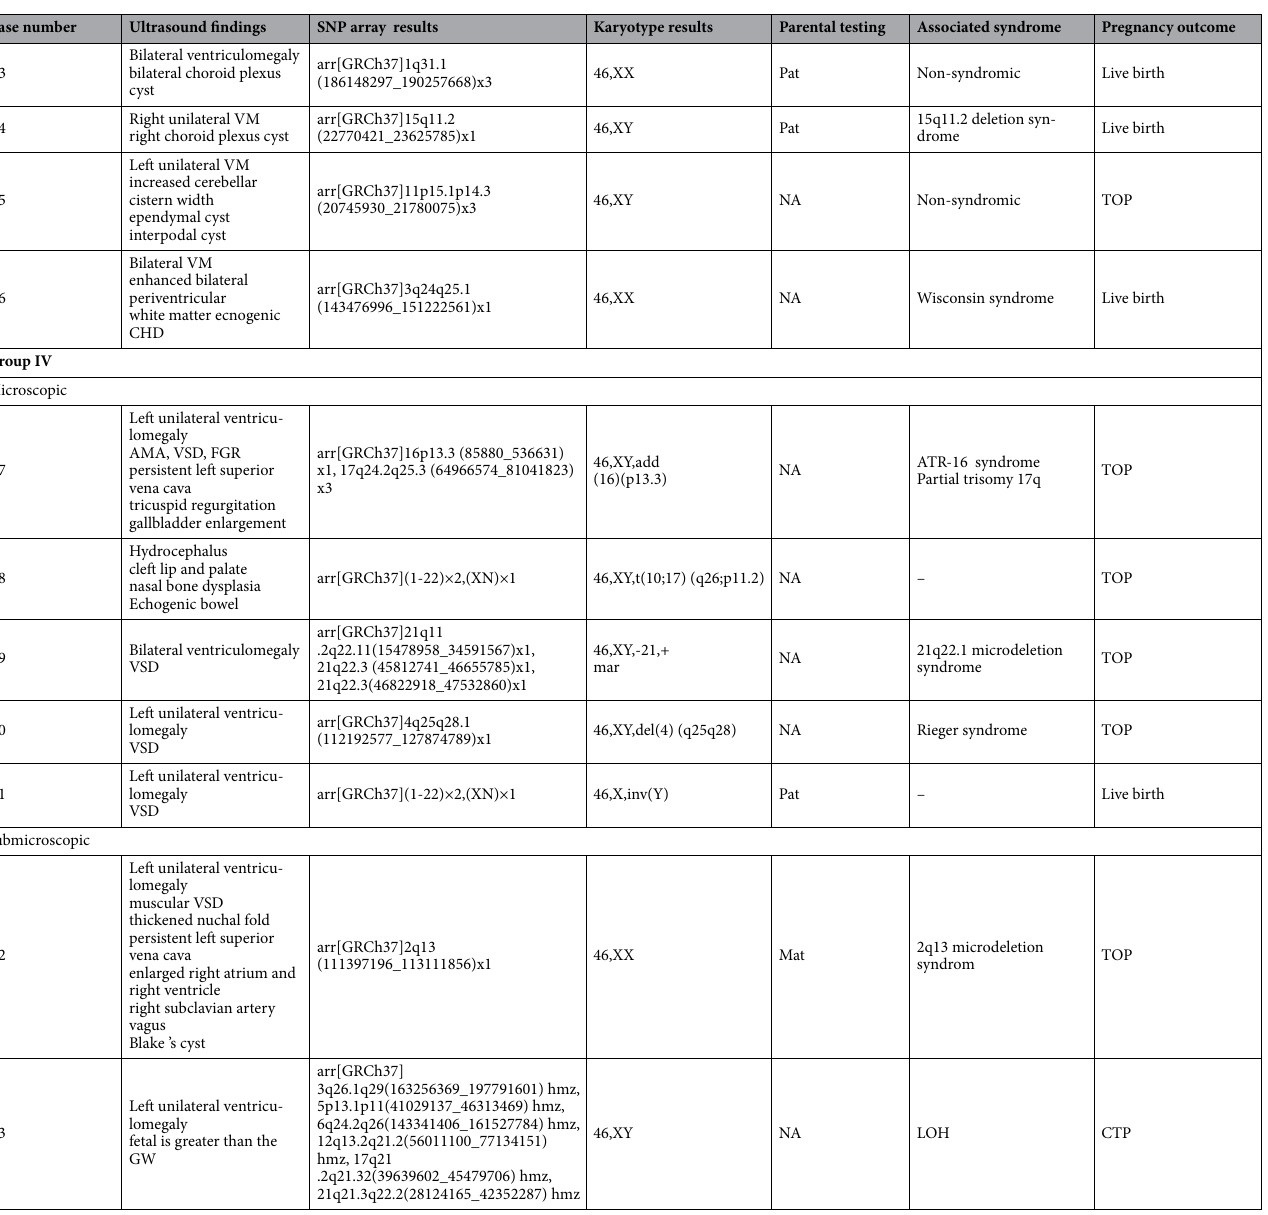
Table 3. Details of the fetuses with clinical significant CMA findings in Group I, II, III and IV. CTP continuation of pregnancy, TOP termination of pregnancy, DS down syndrome, Dn de novo, AS angelman syndrome, PWS prader-willi syndrome, SNP single nucleotide polymorphism, CNV copy number variation, NT nuchal translucency, Pat paternal, Mat maternal, CSP cavum septum pellucidum, ACC agenesis of the corpus callosum, CDCS Cri-du-chat syndrome, VM ventriculomegaly, VSD ventricular septal defect, FGR fetal growth restriction, LOH loss of heterozygosity, AMA advanced maternal age, GW gestational week, ATR-16 alpha-thalassemia retardation-16 syndrome, NA not available $ For case 7, at present, the child is 1.5 years old, and she is developing normally. & For case 23, Brain MR was reexamined 1 month after birth, and the width of bilateral ventricles was 1.14 and 1.15 cm, respectively, and the child is two years old, and she is developing normally